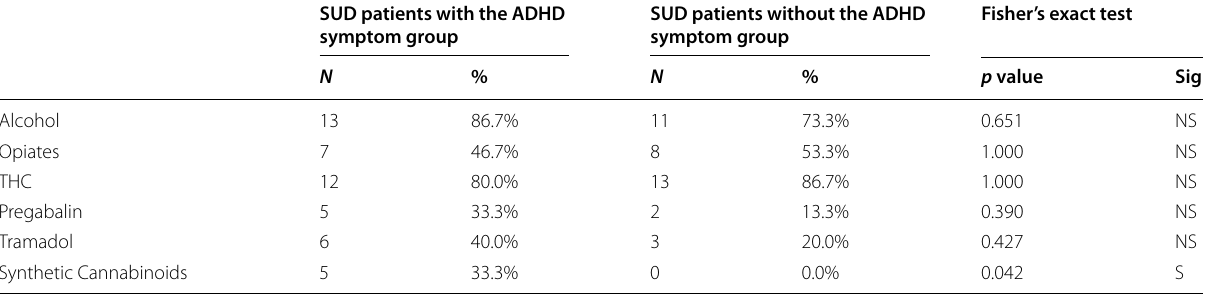
Synthetic Cannabinoids THC Tetrahydrocannabinoids